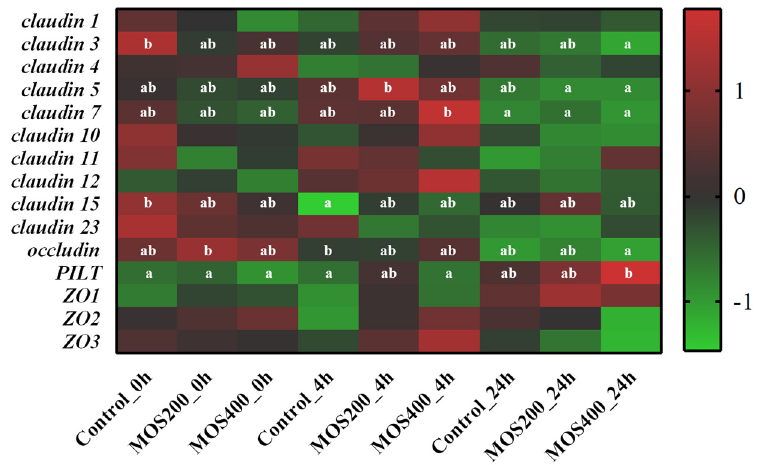
Figure 8. Heatmap of tight junction-related genes based on DGE profiling. The color values represented up-regulated (red) and down-regulated (blue) expressions of selected DEGs, which were ranged from 1 to − 1. Different alphabets indicate statistically significant differences after performing Tukey’s HSD test ( p < 0.05).